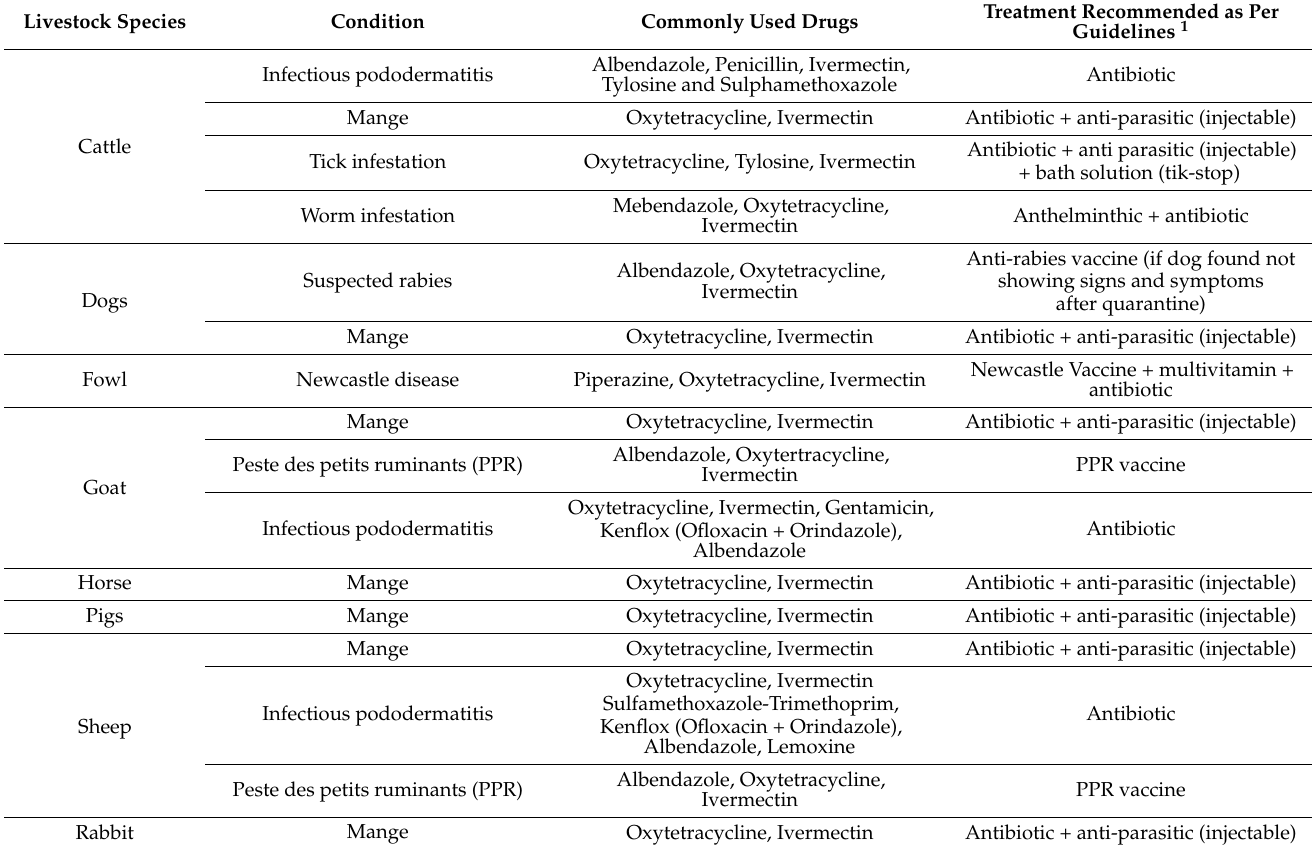
Table 4. Prescription practices by species for common illness in Sierra Leone, March–October